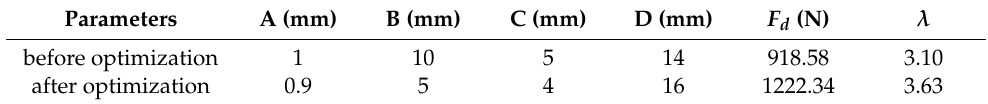
Table 7. Comparison of parameter values between the initial model and the optimized model.